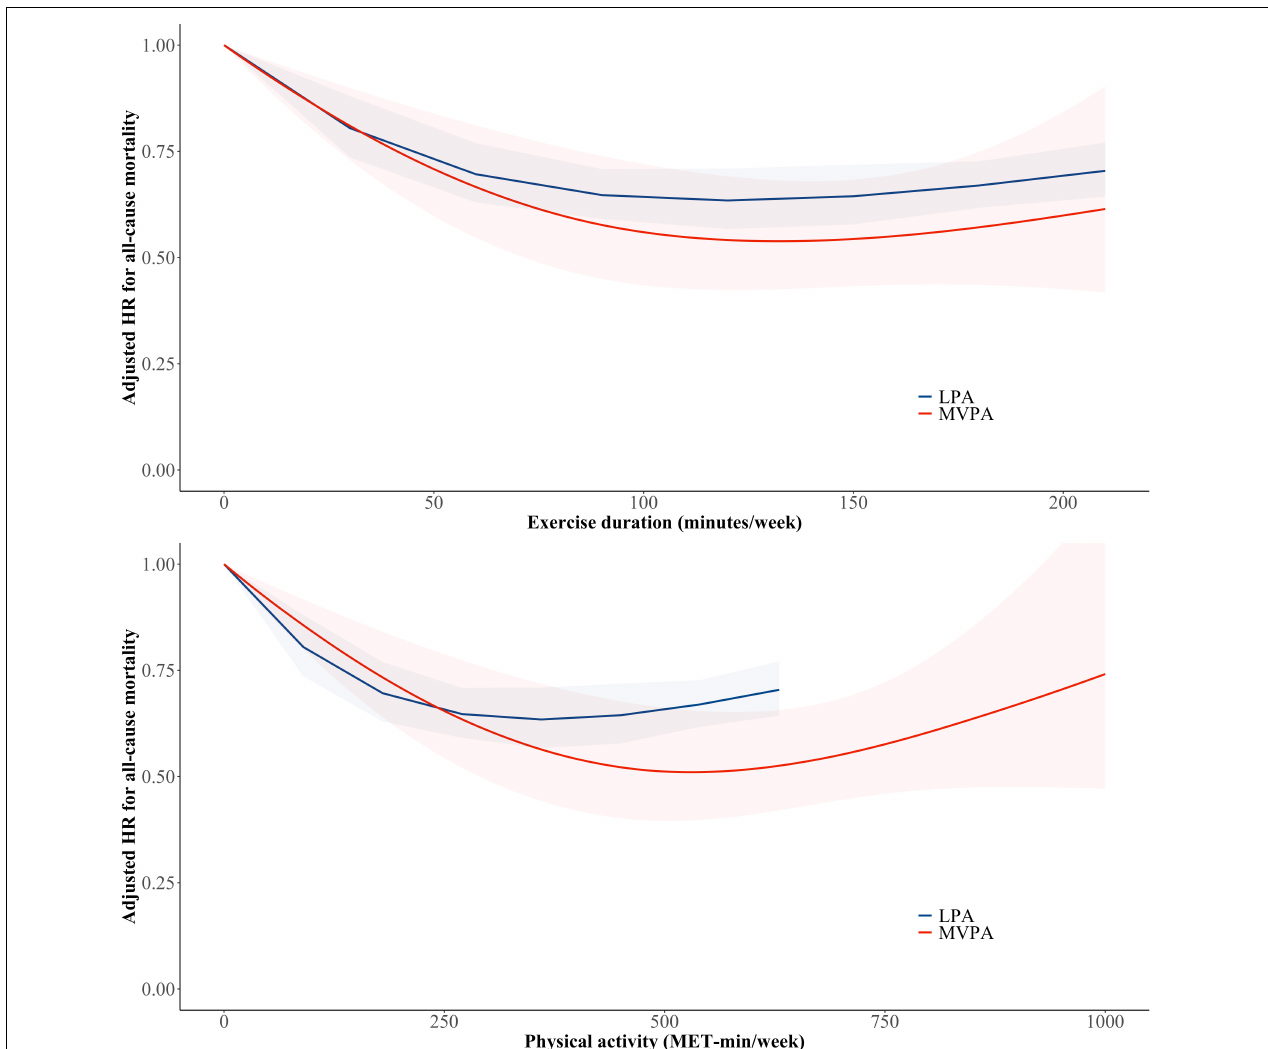
FIGURE 3 | Non-linear relationship between physical activity and all-cause mortality risk according to physical activity intensity. Restricted cubic spline curves were constructed with regard to physical activity treated as a continuous variable. The red and blue lines and shades indicate adjusted hazard ratio and 95% confidence intervals for subjects with light-intensity physical activity and moderate to vigorous physical activity, respectively. LPA, light-intensity physical activity; MET, metabolic equivalent of task; MVPA, moderate- to vigorous-intensity physical